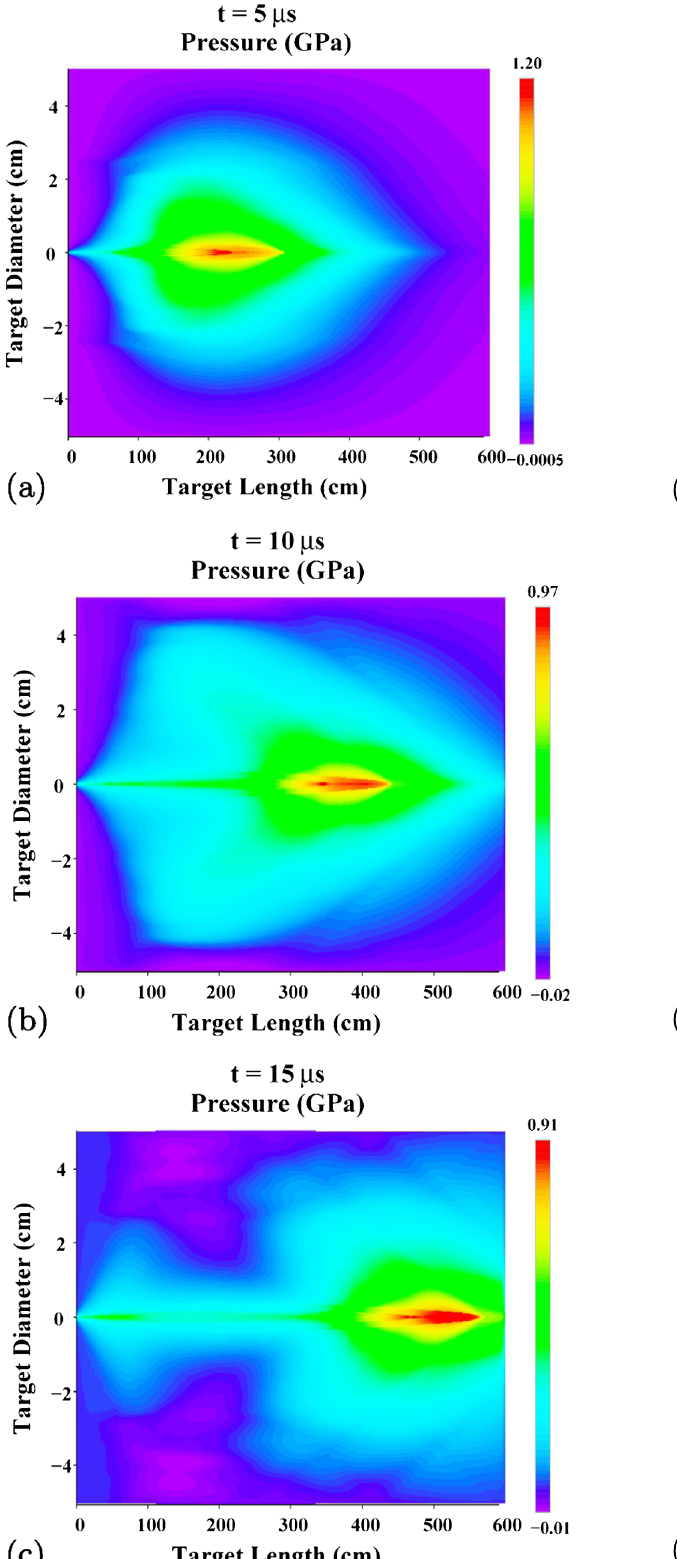
FIG. 6. Pressure distribution calculated by BIG2 in the carbon cylinder, r ¼ 5 cm , L ¼ 6 m , irradiated by the LHC beam at the left face; (a) at t ¼ 5 (cid:2) s ; (b) at t ¼ 10 (cid:2) s ; and (c) at t ¼ 15 (cid:2) s .